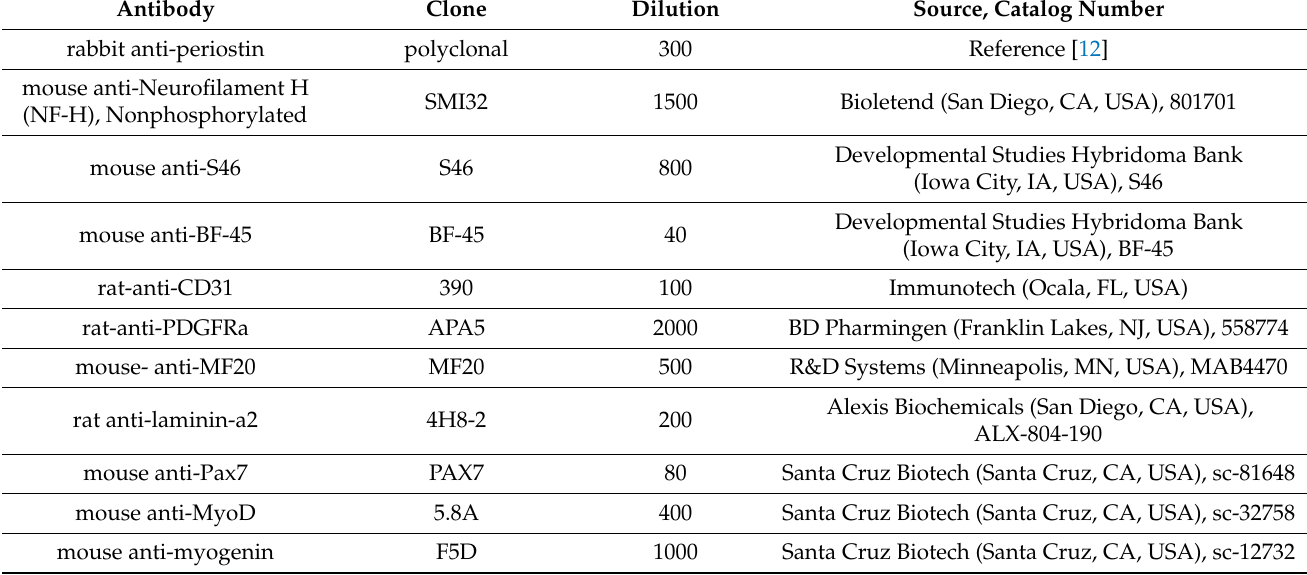
Table 1. Summary of